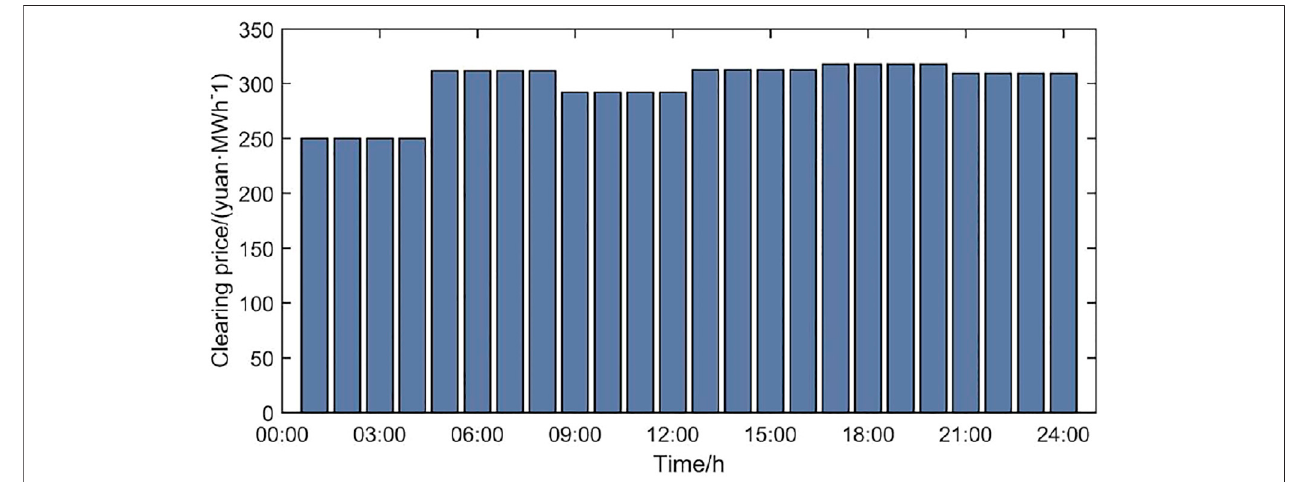
FIGURE 9 | MCP results of the simulation considering 10% wind power